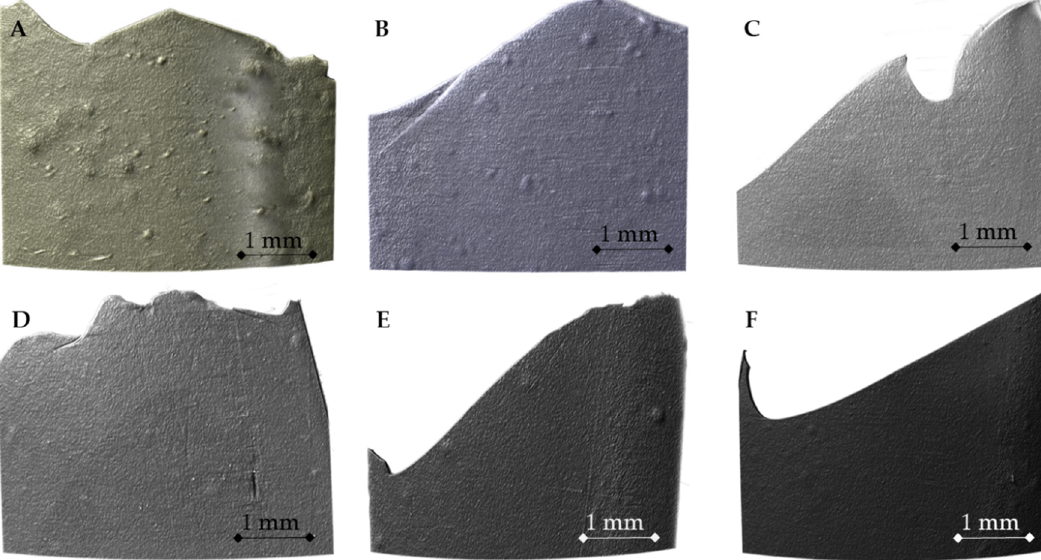
Figure 6. NanoCT images of CHT-GEL ( A ), CHT-GEL-GEN ( B ), CHT-GEL-GEN-GO05 ( C ), CHT-GEL-GEN–GO1 ( D ), CHT-GEL-GEN-GO2 ( E ), CHT-GEL-GEN-GO3 ( F ).